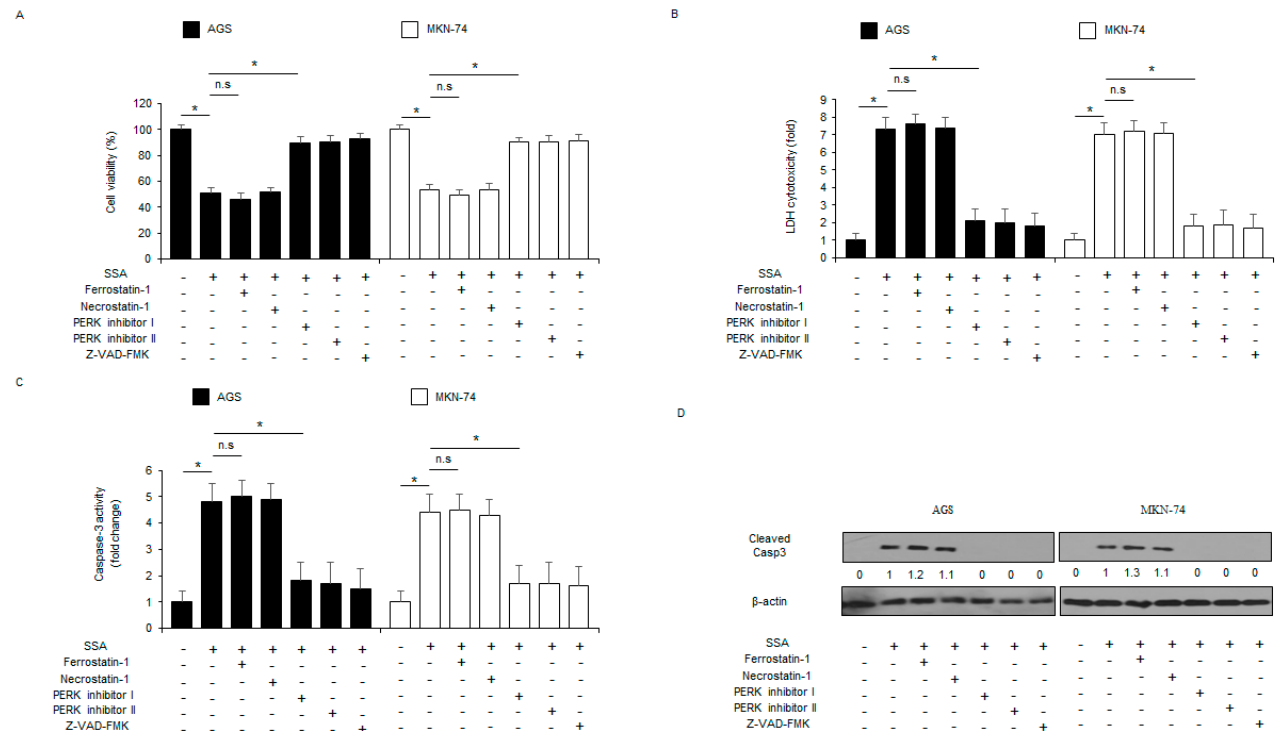
Figure 2. SSA regulates apoptosis and ER stress in GC cells. ( A – D ) The effect of a necroptosis inhibitor (necrostatin-1), a ferroptosis inhibitor (ferrostatin-1), ER stress inhibitors (PERK inhibitors I and II), and a pan-caspase inhibitor Z-VAD-FMK (50 mM, 24 h) on SSA-induced apoptotic cell death. AGS and MKN-74 cells were pretreated with ferrostatin-1 (2 µ M, 24 h), necrostatin-1 (20 µ M, 24 h), PERK inhibitor I (10 µ M, 24 h), PERK inhibitor II (10 µ M, 24 h), and Z-VAD-FMK (50 mM, four hours) and then treated with SSA (10 µ M, 24 h). WST-1, LDH, and caspase-3 activity assays were performed; *, p < 0.05. Total lysates were subjected to Western blot assay to identify apoptosis marker caspase-3 cleavage. β -actin was used as a protein loading